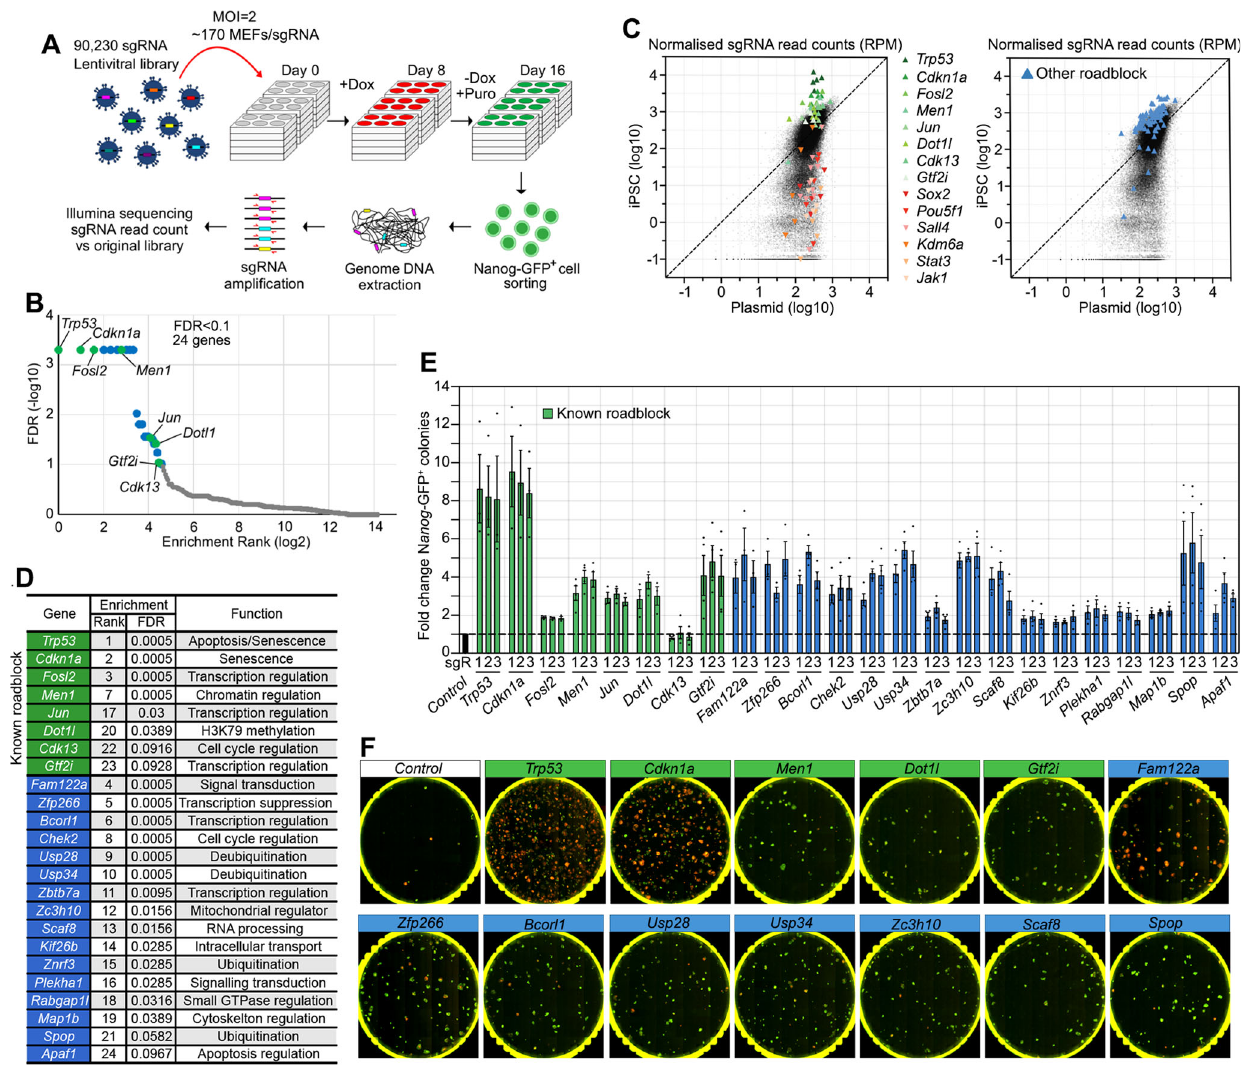
Fig. 1 | A genome-wide CRISPR screen identi fi es reprogramming roadblock genes.A Schematicdiagramofthescreeningstrategy.sgRNAlibraryinfectedCas9 TNG MKOS MEFs were cultured in +dox for 8 days then in -dox and +Puro for additional 8 days. Integrated sgRNAs were ampli fi ed from Nanog -GFP + cells for Illuminasequencing. B EnrichmentFDRrankingwithMAGeCK.24genes,including eight previously reported (green) roadblock genes, were identi fi ed using a cut-off of FDR<0.1. C Normalized sgRNA read counts in the initial plasmid library versus mutantiPSCpool.sgRNAsagainstpreviouslyreportedroadblockgenes(green)and genes essential for reprogramming (red/orange) exhibited expected enrichment/